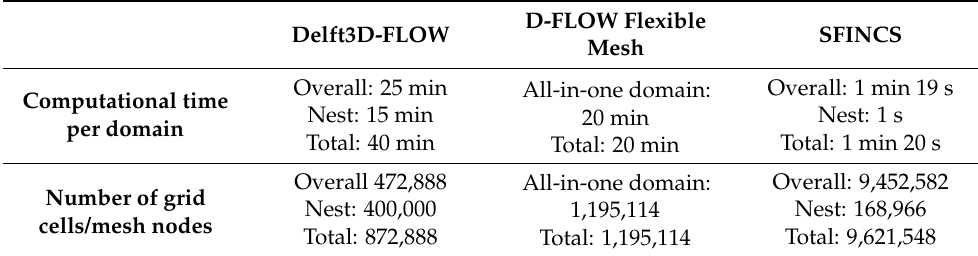
Table 1. Comparison of the computational time and grid cells/mesh nodes per domain of the Delft3D-FLOW, D-FLOW Flexible Mesh (both based on four computational nodes and 4